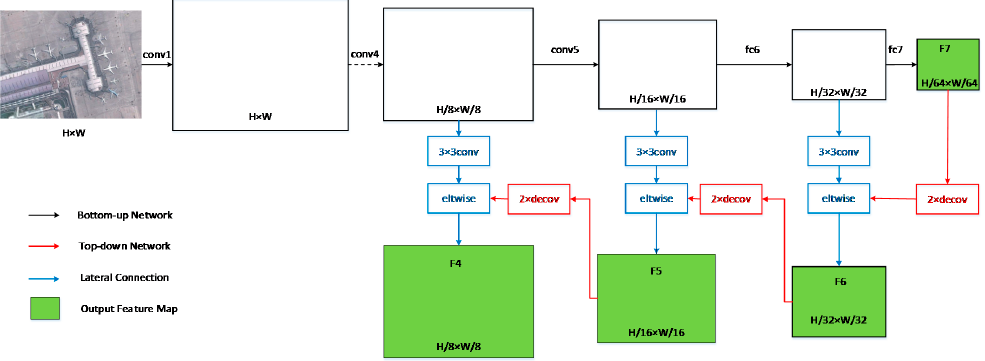
Figure 3. Architecture of the shared multi-scale base network.